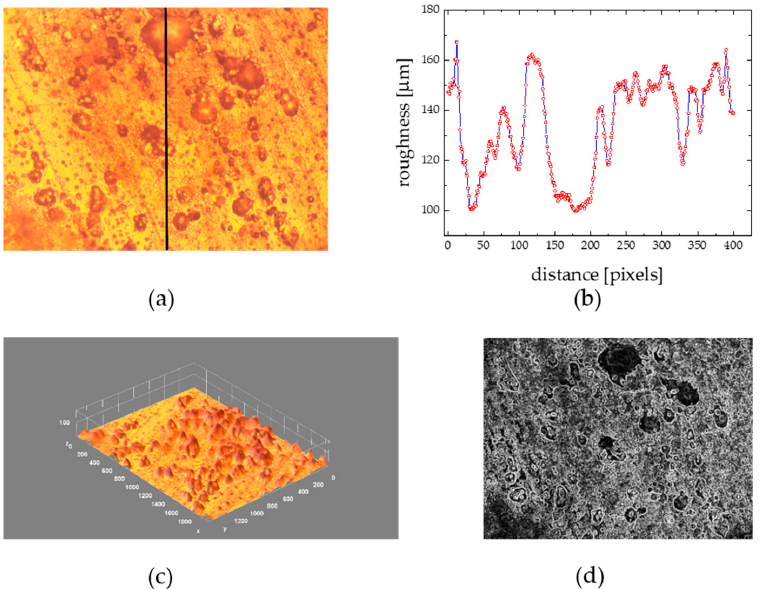
Figure 6. ( a ): A microscopic image of Al flat surface (reference) covered with a marine biofilm (14-day old), collected in Baltic sea water (Gulf of Gda´nsk, Poland; August, 2018); ( b ): roughness height profile along the line from ( a ), ( c ): 3D surface morphology from ( a ) derived with ImageJ routine, ( d ): ( a ) processed with “find edges” procedure; covered area x = 660 and y = 520 μ m. Distance scale 180 pixels = 50 μ m; morphology parameters: surface coverage f = 28.7%, mean thickness = 9 μ m, biovolume = 24,500 μ m 3 , roughness fluctuation coefficient η = 0.141, fractal dimension = 1.16, Hopkin’s aggregation index = 2.14, AC = 0.25.